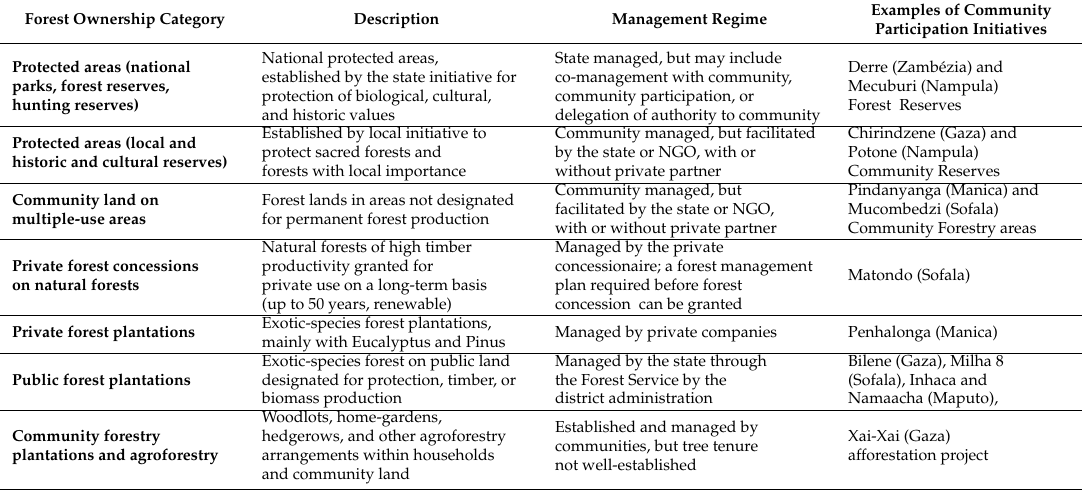
Table 2. Forest management regimes in Mozambique and options for community